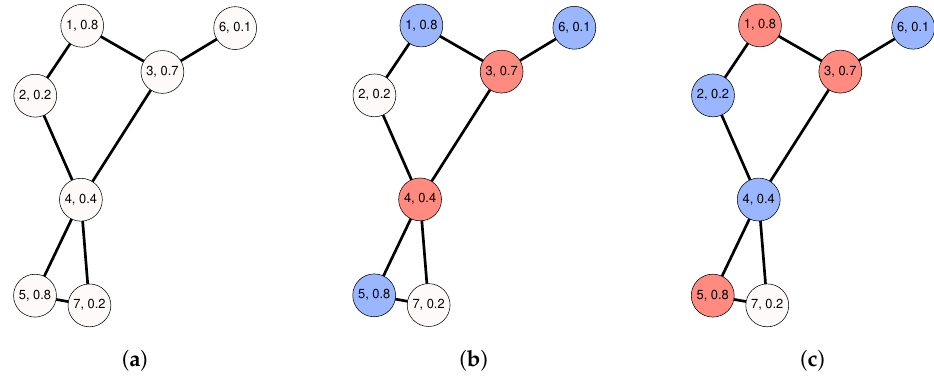
Figure 1. An illustrative example of the MWDDS problem. ( a ) Problem instance; ( b ) Feasible solution D = {{ 3,4 } , { 1,5,6 }} , with f ( D ) = 0.5; ( c ) Optimal solution D ∗ = {{ 1,3,5 } , { 2,4,6 }} , with f ( D ∗ ) =